Question: What direction does the quantity move in — increasing or decreasing?
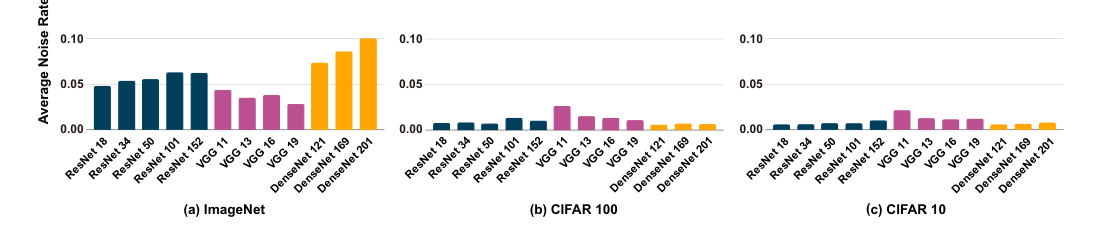
Answer: increasing